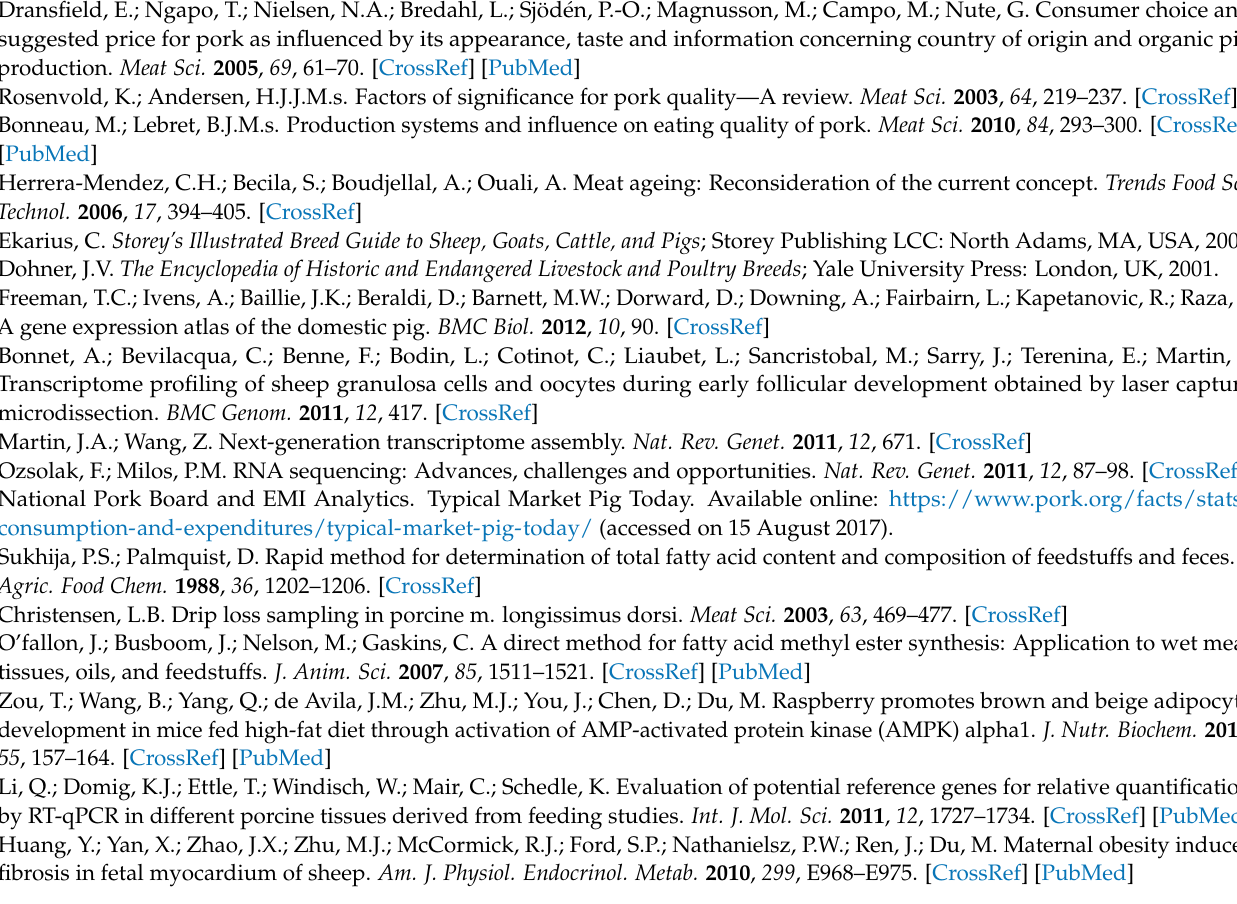
Large Black pigs, Table S2: Raw data of RNA sequencing. Pig_W: Cross-bred commercial pigs, Pig_B: Large Black pigs, Figure S1: Alignment distribution plots. Percentage bases aligned to region. Pig_W: Cross-bred commercial pigs, Pig_B: Large Black